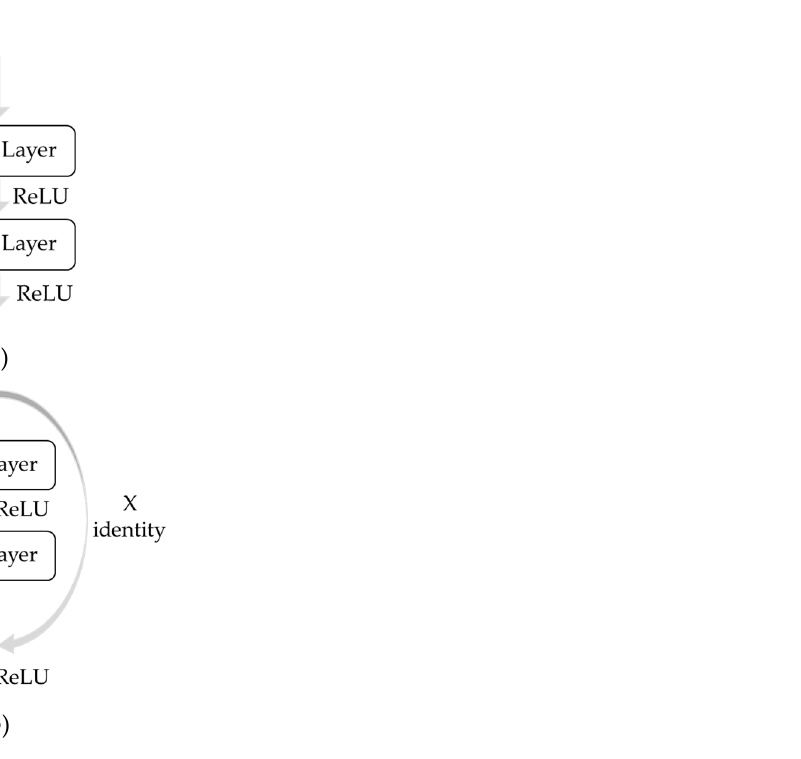
Figure 3. Original convolution layer and residual learning block. ( a ) Original convolution layer; ( b ) residual learning block.